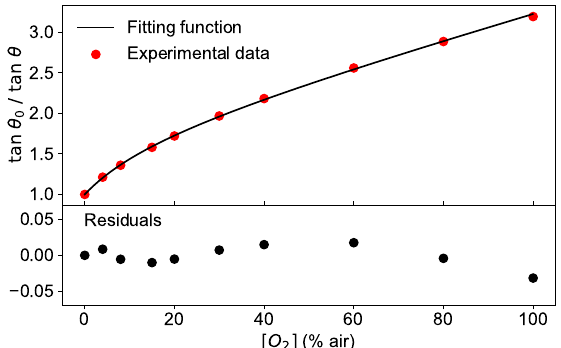
Figure 9. ( top ) Phase shift measured at a modulation frequency of 6 kHz and at the temperature of 45 ◦ C for various values of oxygen concentration (circles). The line is the fit obtained with the Equation (4). ( bottom ) Residuals of the